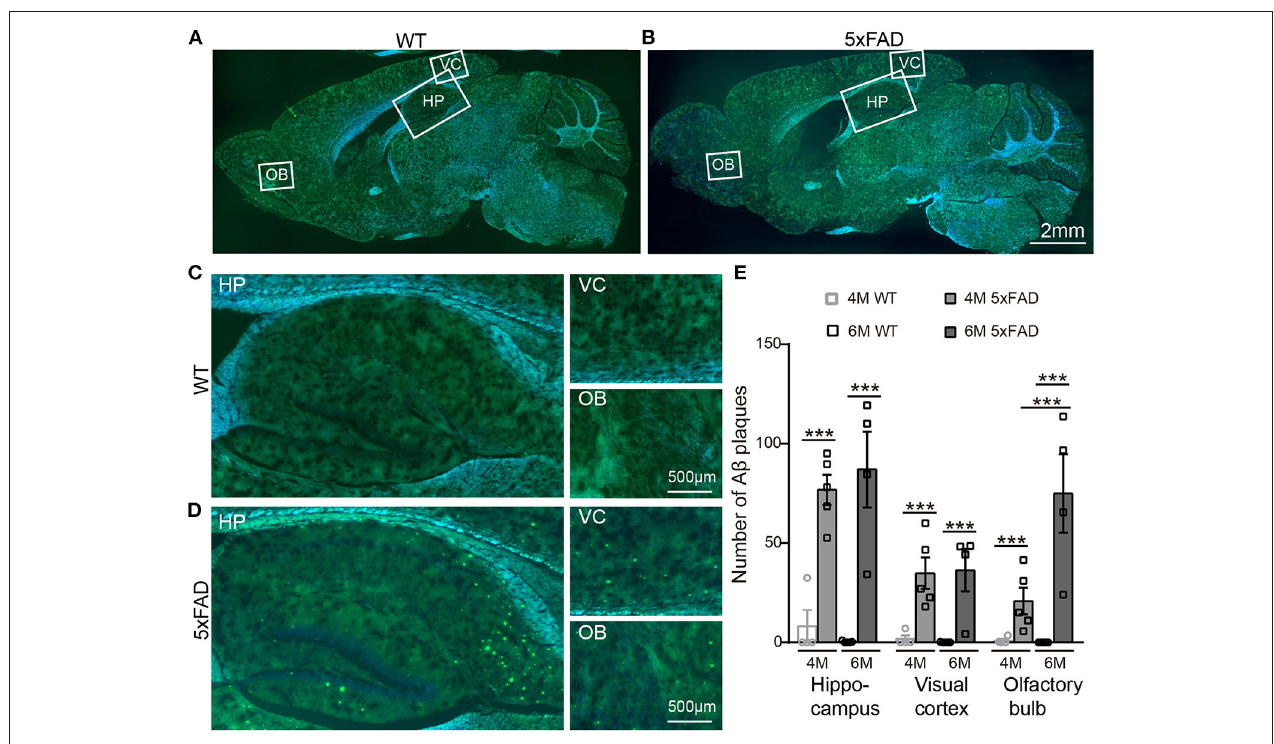
FIGURE 2 | A β plaques appear in various brain regions of 5xFAD mice already at 4 months. (A,B) Images of brain slices stained with thioflavine S (green) that labels A β plaques from a (A) WT and (B) 5xFAD mice. Brain regions including olfactory bulb (OB), hippocampus (HP), and visual cortex (VC) were enlarged in Panels (C) and (D) , respectively, for WT and 5xFAD. (E) Number of A β plaques in different brain regions of WT and 5xFAD at 4 and 6 months. At 4 months, 5xFAD mice have more A β plaques in the brain than WT. Data shown as mean ± SEM. *** p < 0.001, two-way ANOVA test.